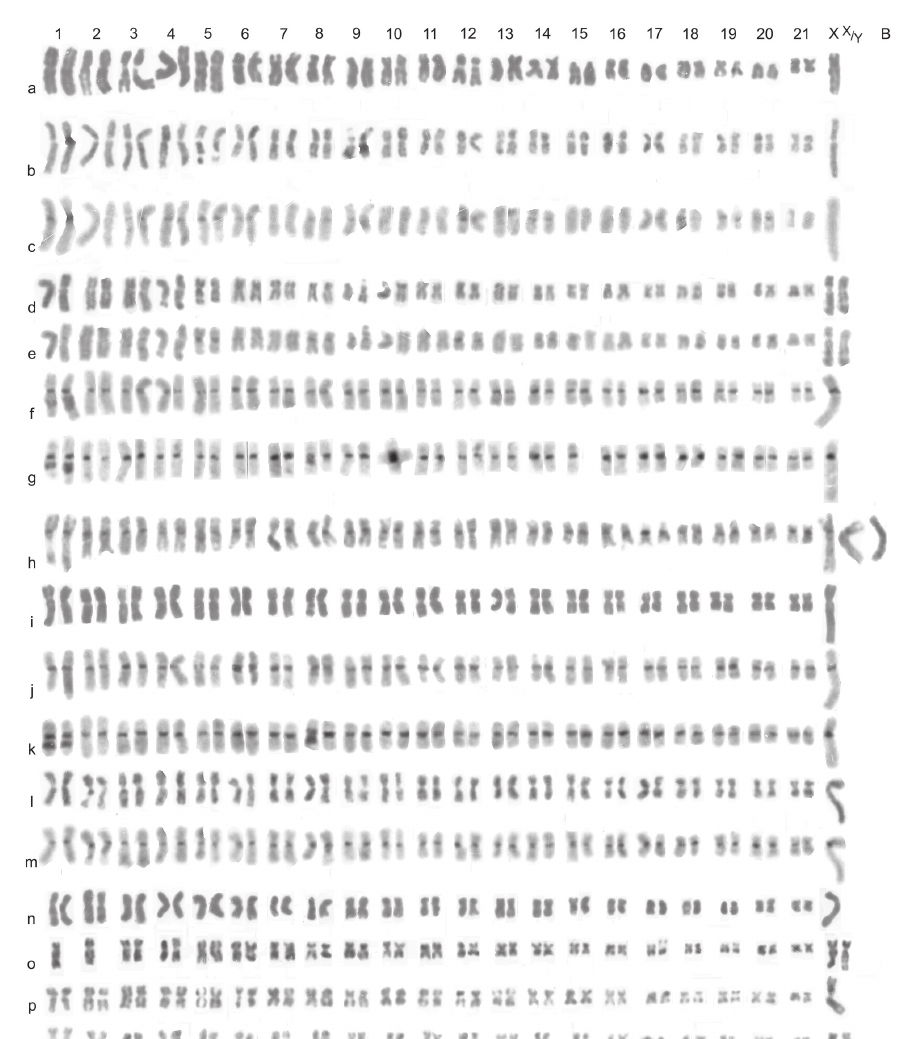
Figure 1. Agabus s. str . ( a–e ) and A . ( Acatodes ) ( f – q ), mitotic chromosomes arranged as karyotypes. a A. serricornis , ♂ , mid-gut, plain b , c A. labiatus , ♂ , mid-gut b plain c C-banded d , e A. labiatus , ♀ , mid-gut d plain, e C-banded f , g A. congener , ♂ , Scotland, testis, C-banded h A. congener , ♀ , Sweden, mid-gut, C-banded, with 1 B-chromosome i – k A. lapponicus , ♂ , Sweden, testis i plain j , k C-banded l , m A. thomsoni , ♂ , mid-gut l plain m the same nucleus C-banded n , o A. confinis , ♀ , mid-gut, plain n lacking one X chromosome o lacking one replicate each of autosomes 1 and 2 p A. sturmii , ♂ , mid-gut, plain q A . infuscatus , ♂ , mid-gut, plain. Bar = 5μm. A. labiatus (Brahm, 1791). Fig. 1 b, c ( ♂ ), Fig. 1 d, e ( ♀ ). Published information: none. 2 n = 42 + X0 ( ♂ ), 42 + XX ( ♀ ). The autosomes, all either metacentric or